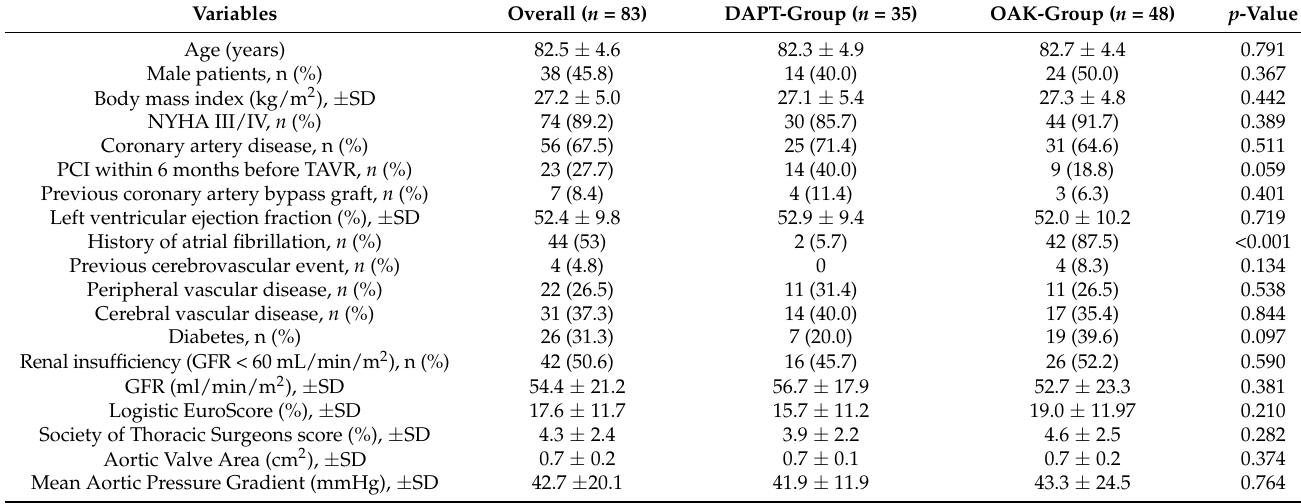
Table 1. Baseline demographic and clinical characteristics of the study population (DAPT vs. OAK).